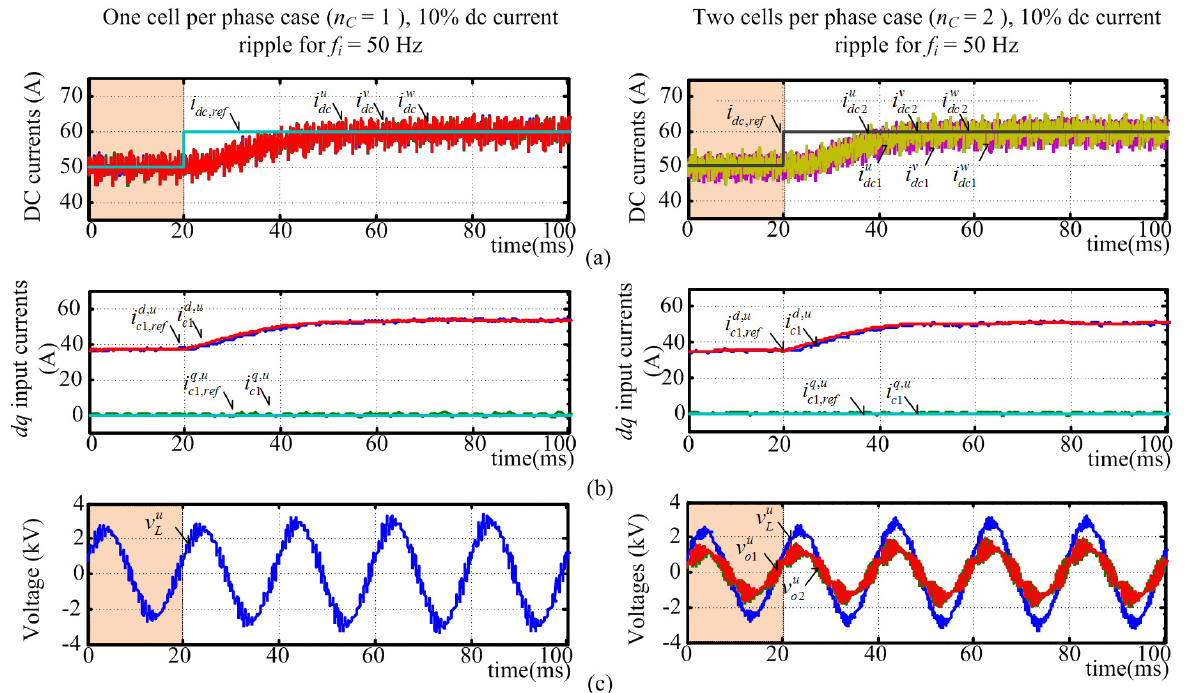
Figure 5. DC controller performance for 20% reference step change: ( a ) DC current; ( b ) dq input currents and their references; ( c ) output voltage and load voltage.